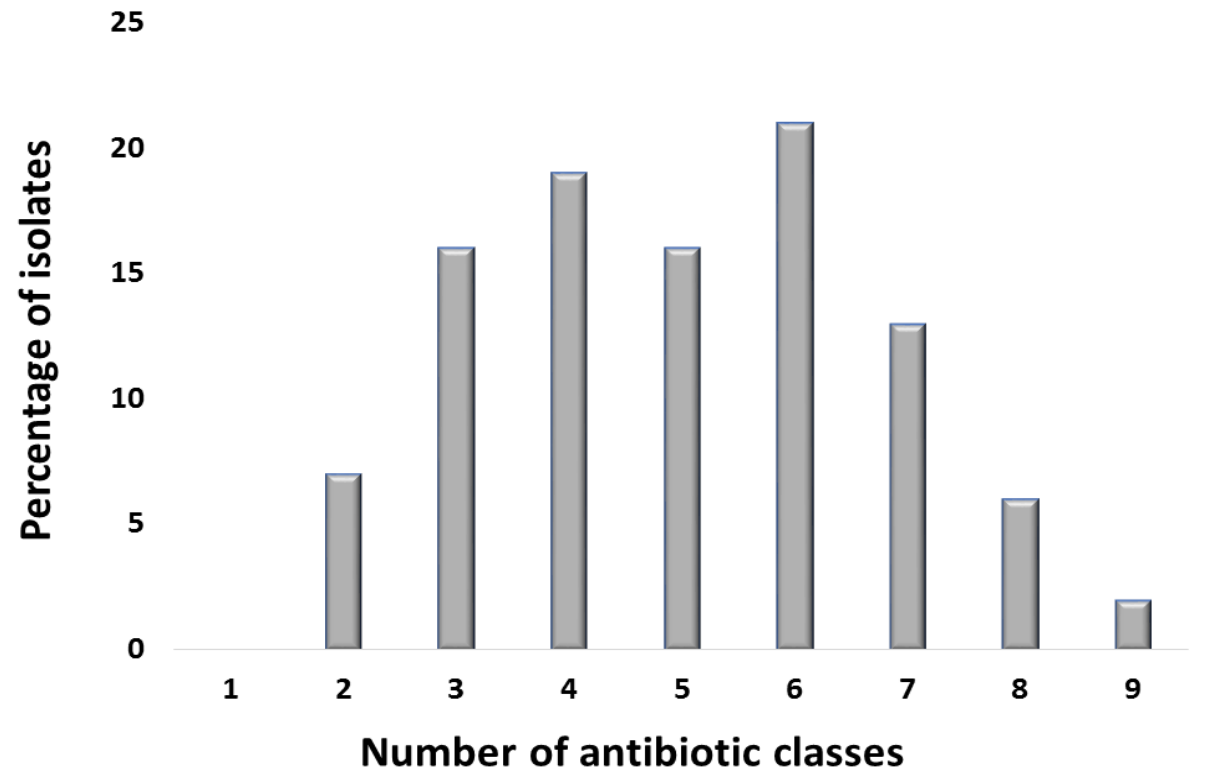
Figure 4. Bar chart showing the number of E. coli isolates resistant to different antibiotic classes tested. The x-axis shows the number of antibiotic classes, while y-axis shows the percentage of E. coli isolates resistant to specific number of antibiotic classes. The antibiotic classes that were used for antibiotic-susceptibility profiling include: (I) penicillin, (II) tetracycline, (III) penicillin β -lactamase inhibitor, (IV) carbapenem, (V) fluoroquinolone, (VI) aminoglycoside, (VII) cephalosporin, (VIII) nitrofuran, (IX) phenicol, (X) macrolide, (XI) Colistin, and (XII) sulfonamide. 3.3. Location and Phylogenetic Groups Affecting Variability in MAR Index and R-Score For further analyses and comparisons, a resistance score (R Score) and MAR index were defined. Overall, 116 E. coli isolates (58%) showed a MAR index above 0.2 that is the indicative of high resistance in that specific isolate (Figure 5A,B). To test whether the location of the isolates had any effect on the level of resistance, their resistance score and MAR index were compared. Overall, the highest MAR index was observed in samples from Kallar Syedan, followed by Islamabad and Kotli Sattian. The lowest MAR index was observed in the samples collected from Taxila, followed by Rawalpindi and Gujar Khan (Figure 5C). The R-score showed the same results as the MAR index; the highest R-Score was observed in samples from Kallar Syedan, followed by Kotli Sattian. The lowest R-Score was observed in the samples collected from Taxila (Figure